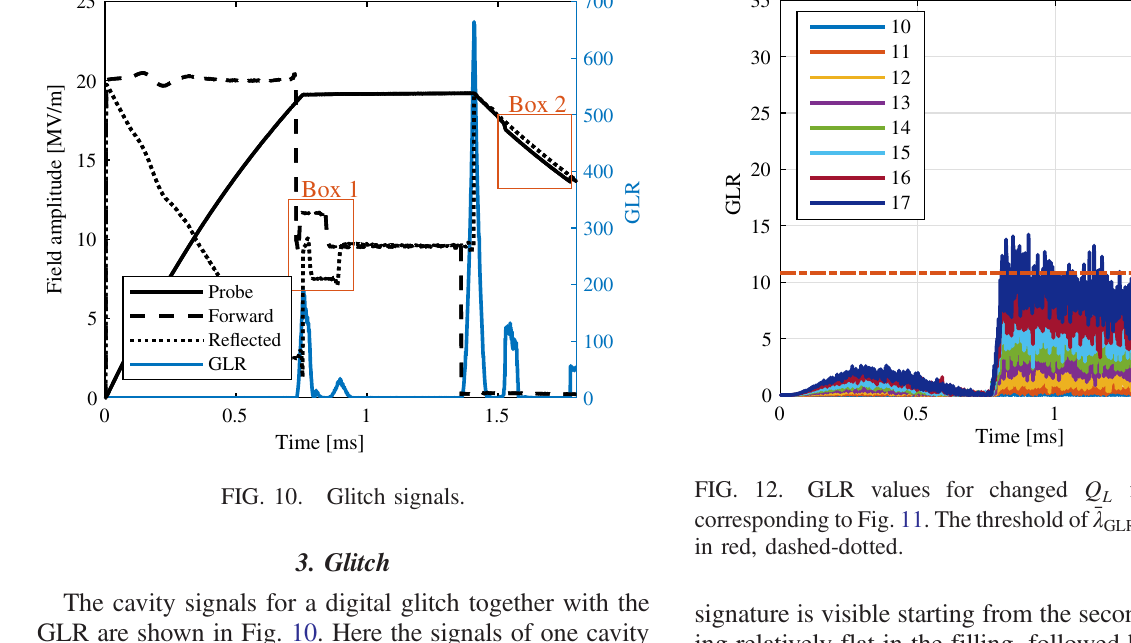
FIG. 10. Glitch signals.